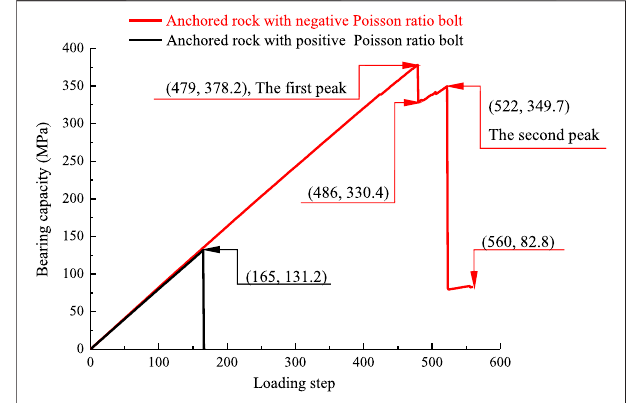
FIGURE 7 | Stress curve of two different anchored